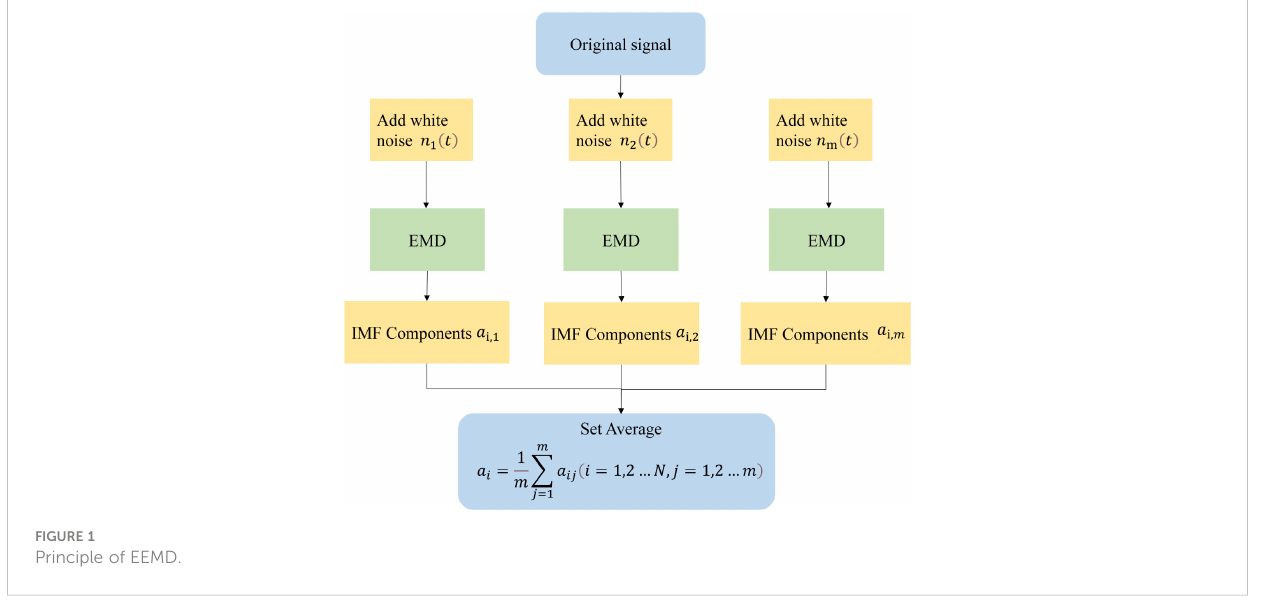
FIGURE 1 Principle of